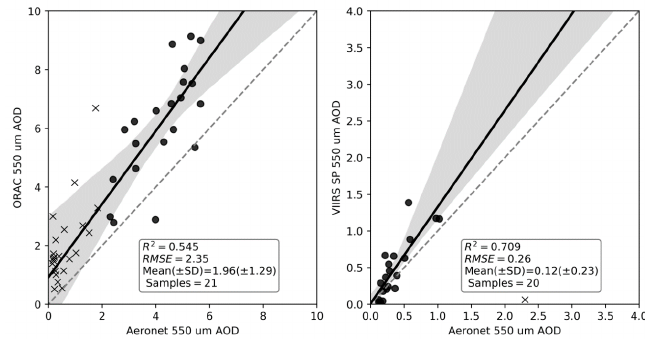
Figure A1. Intercomparison between collocated AOD retrievals made from VIIRS using ORAC [52] and the official VIIRS IP AOD product [49], both conducted at 550 nm and for the set of SE Asian fires focused on herein. ORAC was able to retrieve AODs significantly higher than those present in the VIIRS IP AOD product, so the scales of the two graphs are different. The OLS linear best fit through each set of data is shown in both cases, and at left the crosses relate to points with AOD < 2.0.